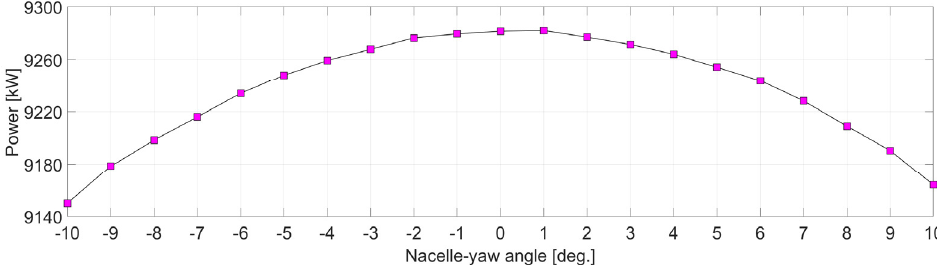
Figure 11. Average of the absolute values of output parameters according to nacelle–yaw angle.